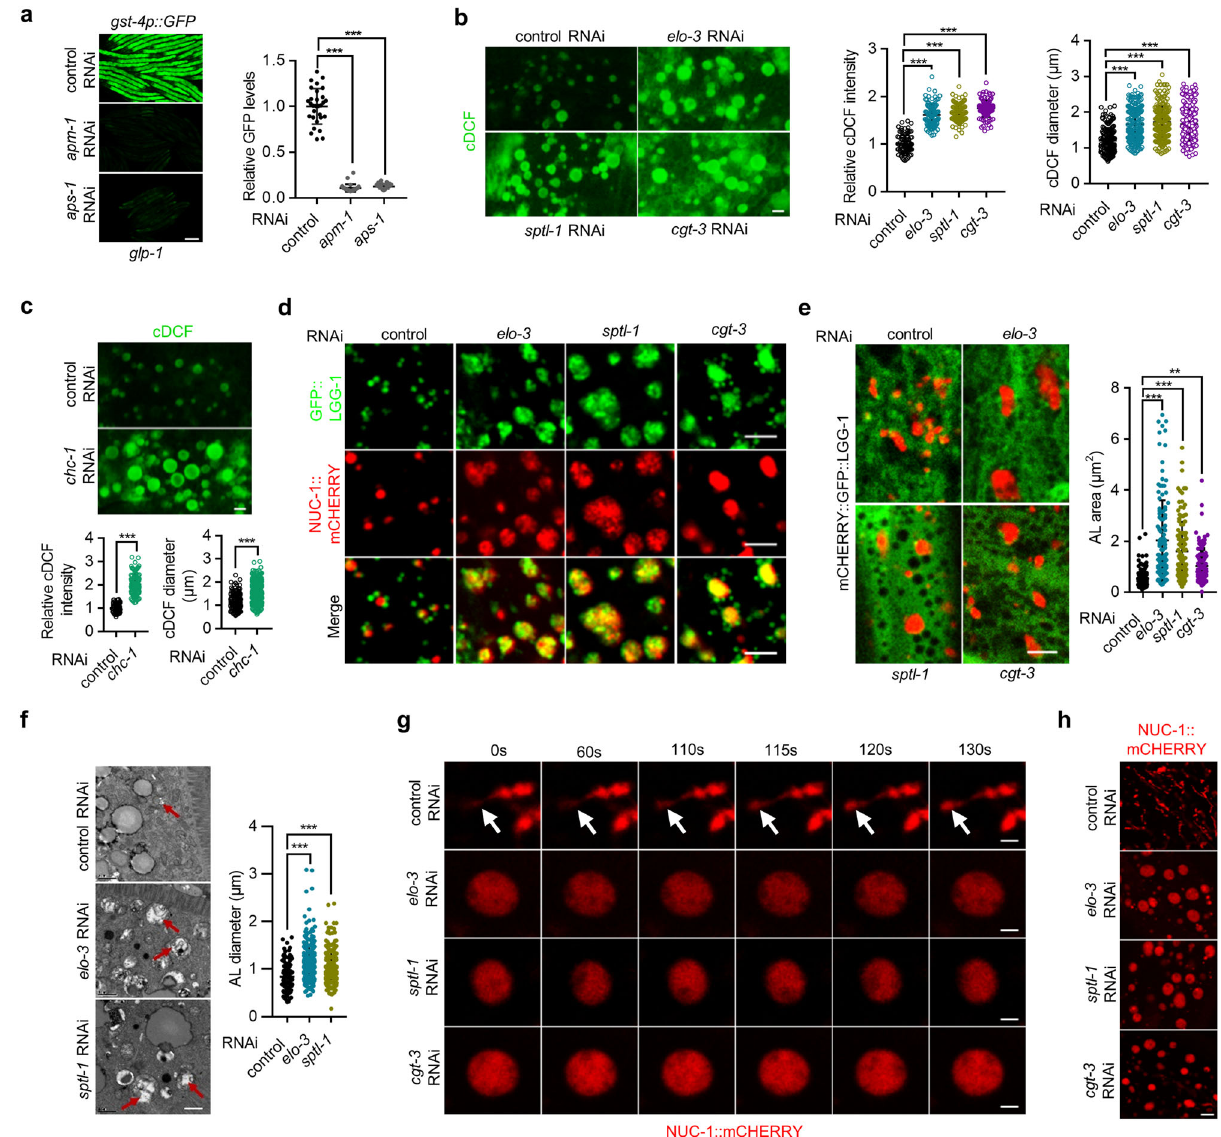
Fig. 6 C22 GlcCer regulates lysosome homeostasis. a Effects of aps-1 and apm-1 RNAi treatment on the expression of gst-4p ::GFP in glp-1 mutants. n = 30 animals. b Effects of elo-3 , sptl-1 , and cgt-3 RNAi treatment on the acidity and size of the lysosomes in the intestine of glp-1 mutants, as determined by cDCFDA staining. n = 105 (control RNAi, elo-3 RNAi, and cgt-3 RNAi) and 104( sptl-1 RNAi) cDCF-positive granules for intensity analysis; n = 205 (control RNAi), 210 ( elo-3 RNAi), 207 ( sptl-1 RNAi), and 211 ( cgt-3 RNAi) cDCF-positive granules for size analysis. c Effects of chc-1 RNAi treatment on the acidity and size of the lysosomes in the intestine of glp-1 mutants. n = 108 (control RNAi) and 113 ( chc-1 RNAi) cDCF-positive granules for intensity analysis; n = 205 (control RNAi) and 204 ( chc-1 RNAi) cDCF-positive granules for size analysis. d Colocalization between GFP::LGG-1 and NUC-1::mCHERRY in the hypodermis of elo-3 , sptl-1 and cgt-3 RNAi-treated worms. e Effects of elo-3 , sptl-1 , and cgt-3 RNAi on the AL area, as measured by the red-only signals from mCHERRY::GFP::LGG-1 in the hypodermis. n = 125 ALs for control RNAi and 129 ALs for elo-3 , sptl-1 , and cgt-3 RNAi. f Effects of elo-3 and sptl-1 RNAi treatment on AL size as revealed by EM analysis of the intestine. Red arrows indicate ALs. n = 115/289/232 ALs for control RNAi/ elo-3 RNAi/ sptl-1 RNAi. g Time-lapse images showing the effects of elo-3 , sptl-1 , and cgt-3 RNAi treatment on lysosome reformation from AL in the hypodermis. White arrows indicate newly formed lysosomes. h Effects of elo-3 , sptl-1 , and cgt-3 RNAi treatment on lysosome morphology in the hypodermis in response to 2-h starvation. Data are represented as mean ± SD. ∗∗ p < 0.01, ∗∗∗ p < 0.001. a, b, e , and f were analyzed by one-way ANOVA with Turkey ’ s multiple- comparison test ( ∗∗∗ p < 0.001, ∗∗ p = 0.0011 for panel e). c was analyzed by unpaired two-tailed t- test ( ∗∗∗ p < 0.001). Scale bar = 100 μ m for panel a , 3 μ m for panels b , c , and d , 2.5 μ m for panel e , 1 μ m for panels f and g , and 4 μ m for panel h . Source data are provided as a Source Data fi